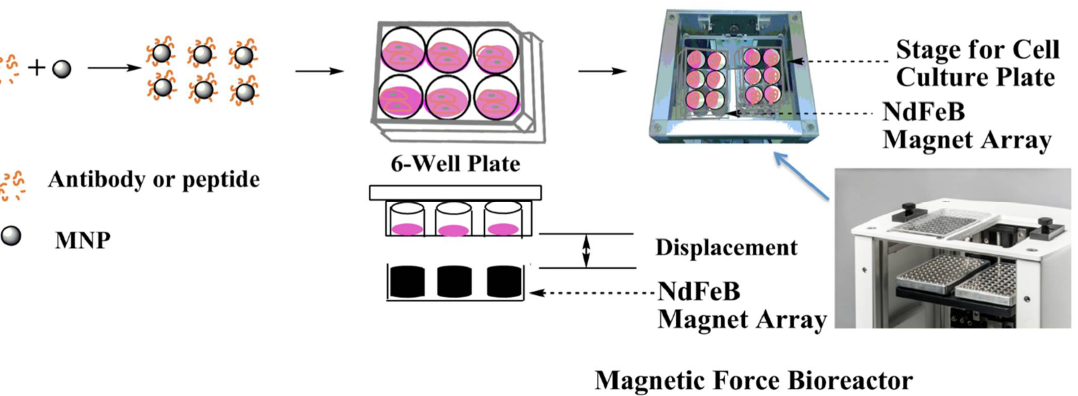
Figure 3. Schematics of the nanomagnetic actuation technique using a magnetic force bioreactor (MFB). MNPs are first functionalized with antibodies or peptides and then incubated with cells. After removing unbound MNPs, cells are exposed to a high-gradient, time-varying magnetic field generated by vertically oscillating NdFeB magnet arrays mounted on stepper motors under computer control [17].